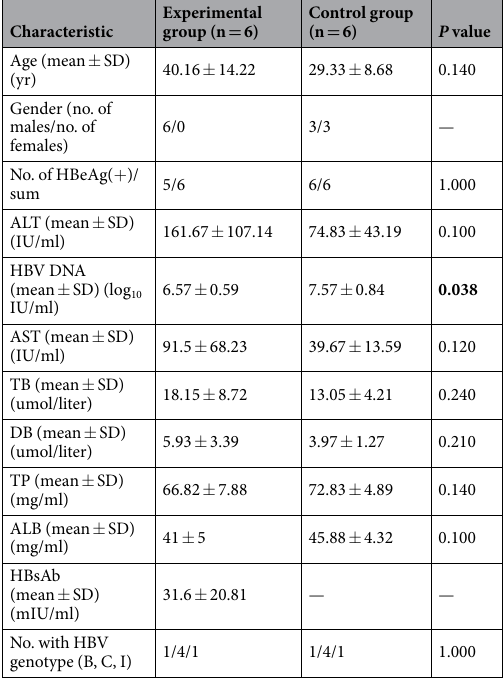
Table 1. Demographic and clinical features of studied